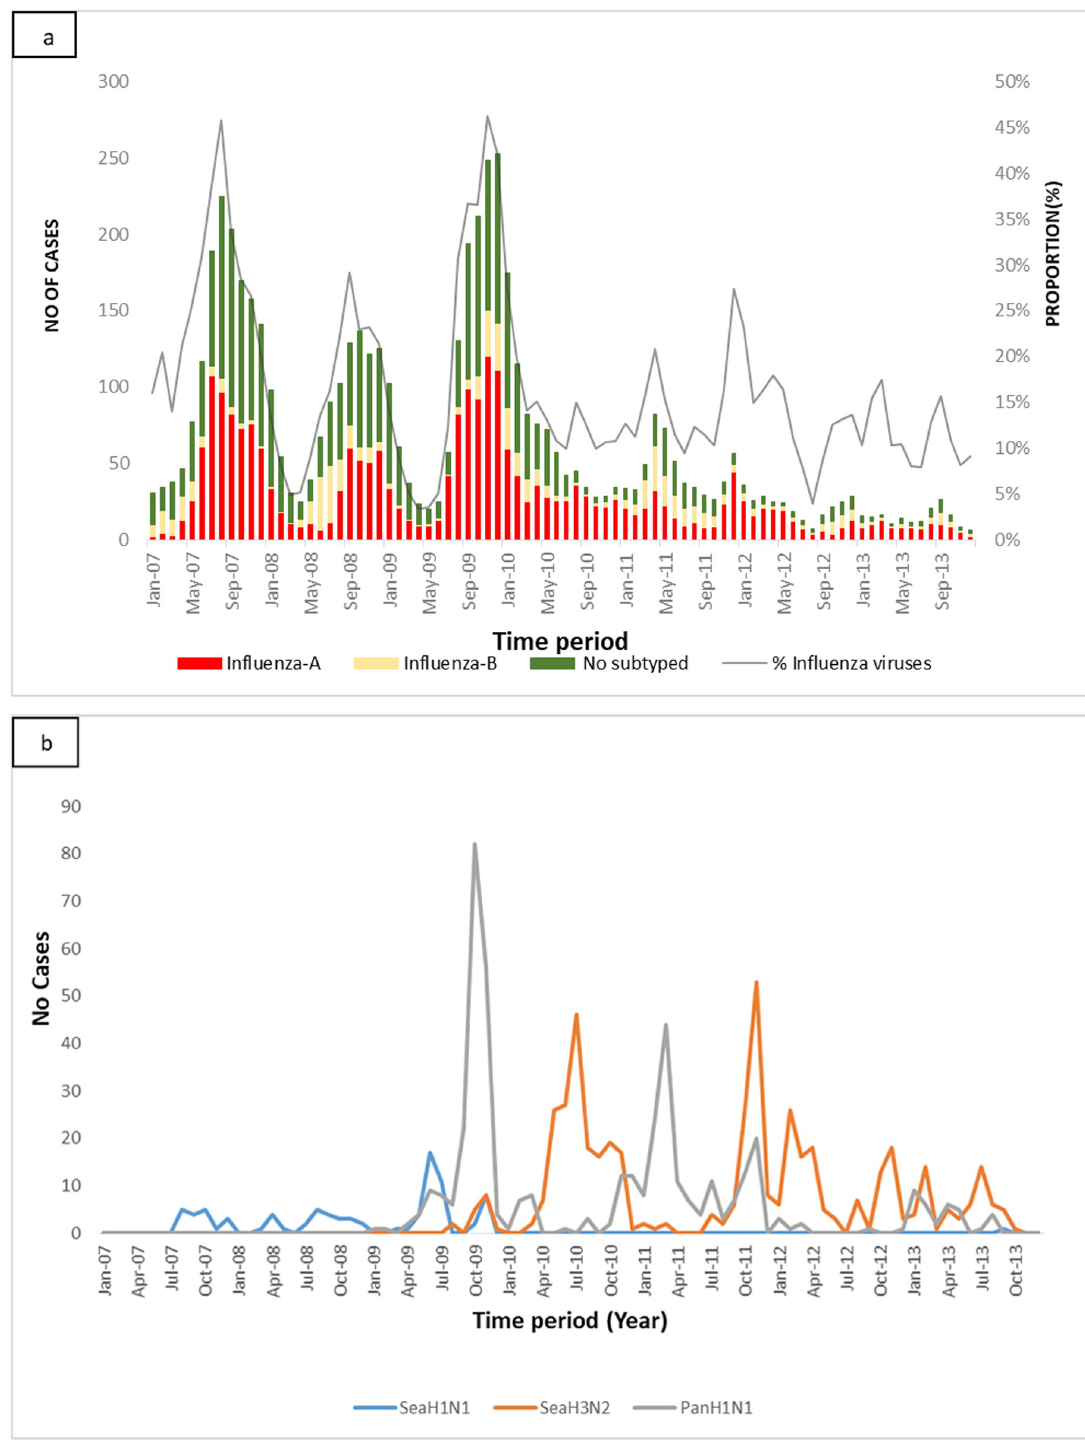
Fig 3. a . Influenza viruses monthly trends by Influenza-like Illness (ILI) surveillance program, Kenya. b . Influenza virus A subtypes monthly trends by Influenza-like Illness (ILI) surveillance program, Kenya.